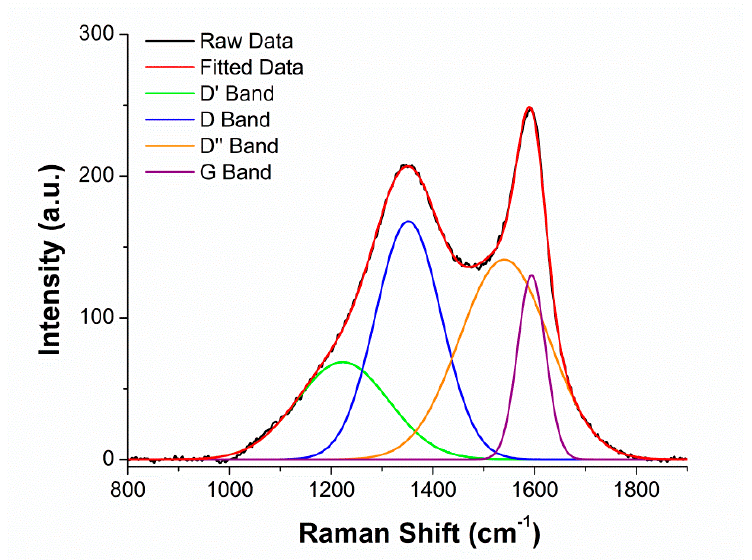
Figure 1. Raman spectra of Miscanthus BC pyrolyzed at 650 °C and after 24 h of ball milling.